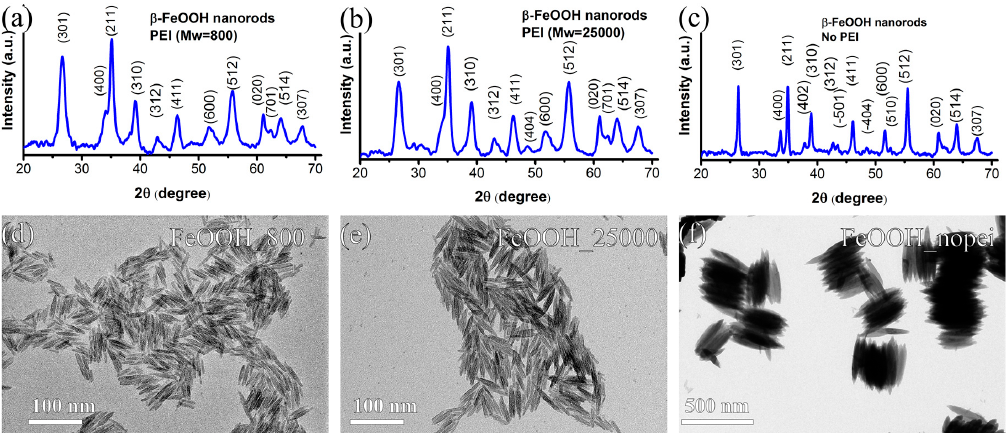
Figure 1. XRD patterns and conventional TEM images of the samples FeOOH_800 ( a , d ); FeOOH_25000 ( b , e ); and FeOOH_nopei ( c , f ).